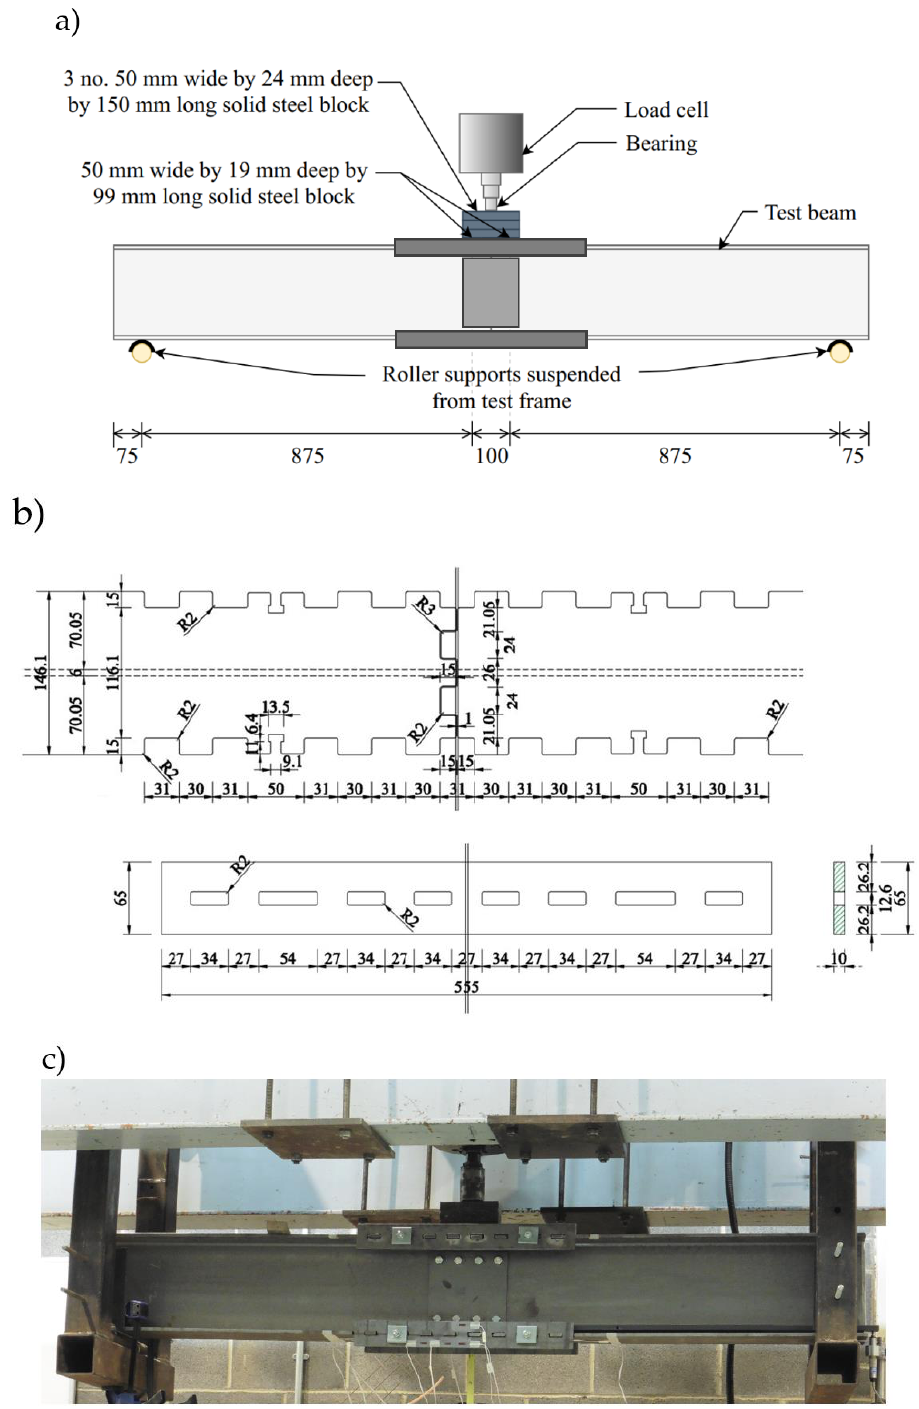
Figure 12. Beam test-B general arrangement. ( a ) general arrangement; ( b ) main dimensions; ( c ) test setup.